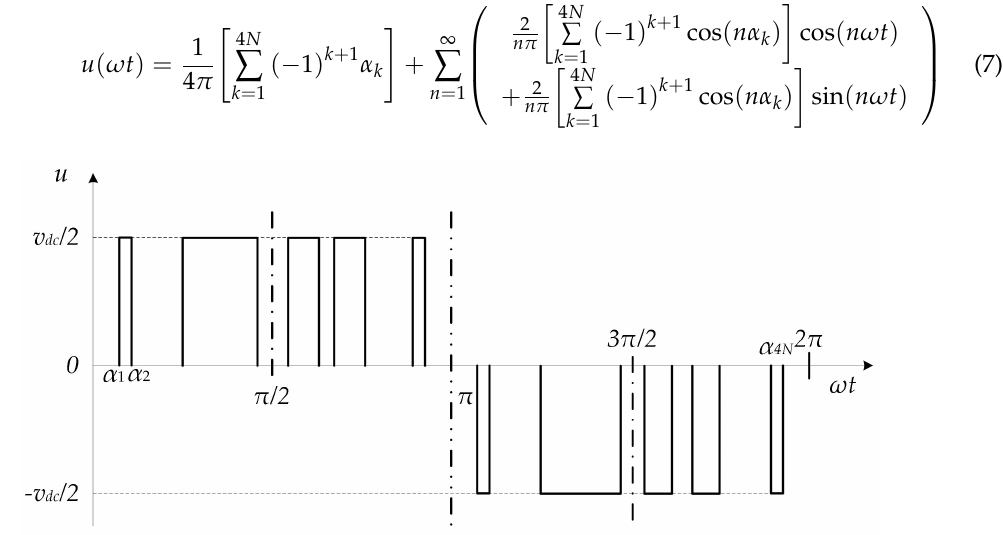
Figure 5. Three-level waveform with